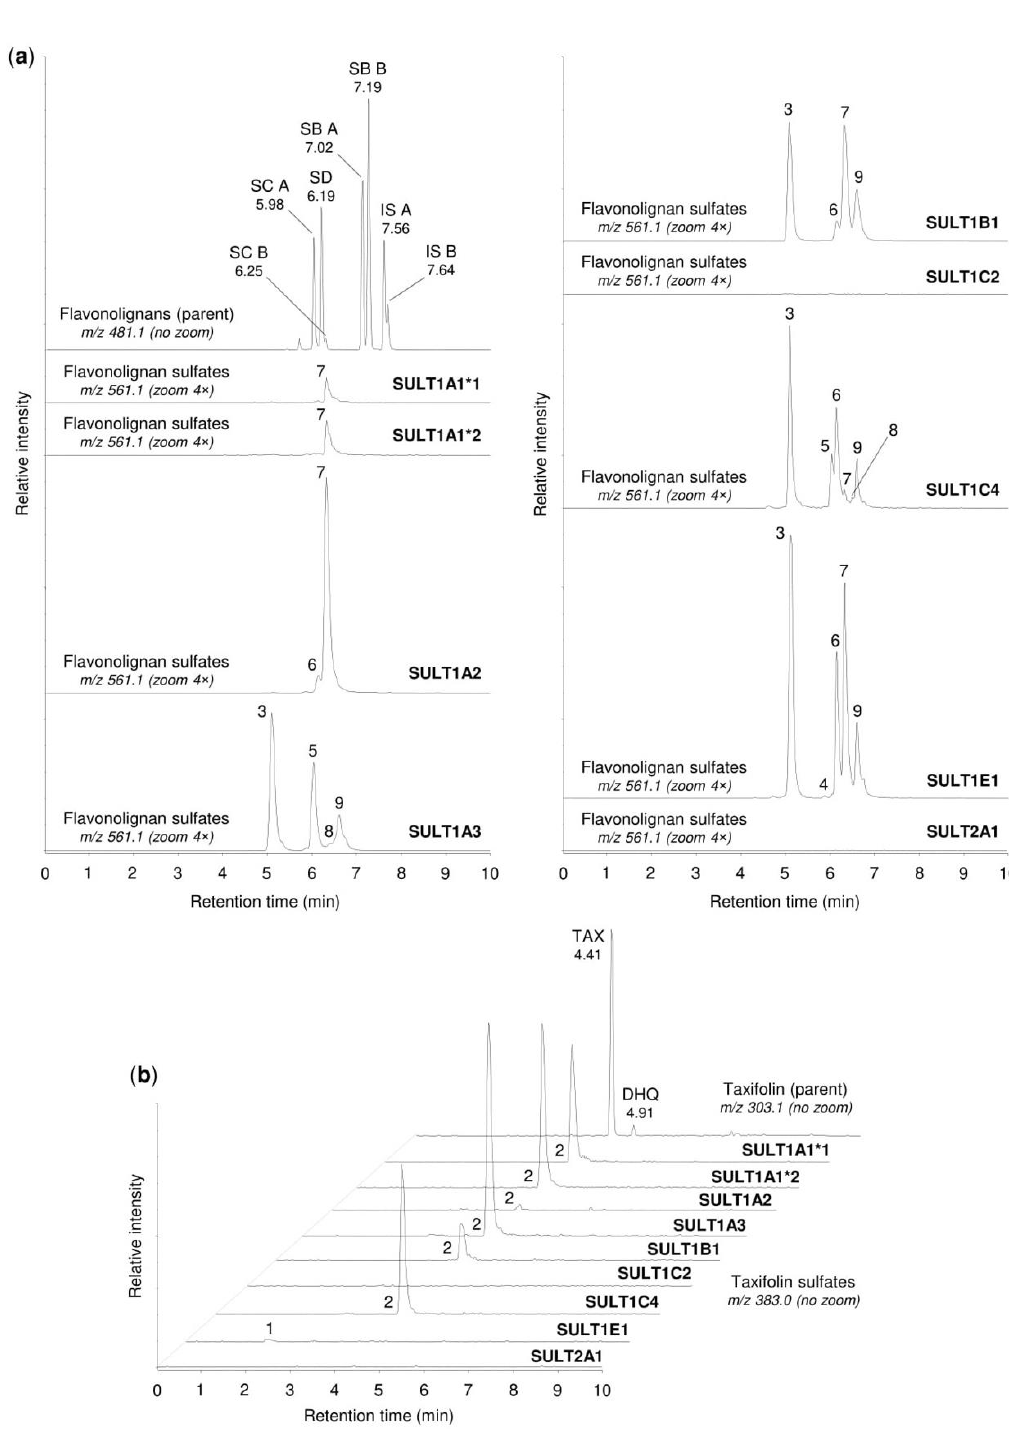
Figure 2. Sulfation of silymarin mixture by human sulfotransferases. Silymarin (50 µ M) was incubated for 30 min with recombinant human SULTs 1A1*1, 1A1*2, 1A2, 1A3, 1B1, 1C2, 1C4, 1E1, and 2A1, (SB B), isosilybin A (IS A), and isosilybin B (IS B), along with their sulfation products, marked as peaks 3–9. ( b ) The representative chromatograms show the parent taxifolin (TAX), a dihydroquercetin